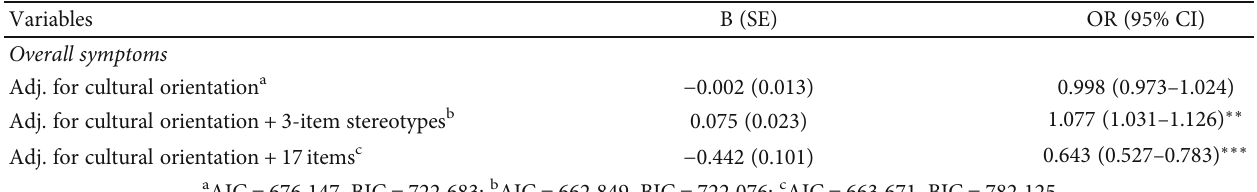
Table 3: Multivariate analysis of gender di ff erences in overall and four-factor depression